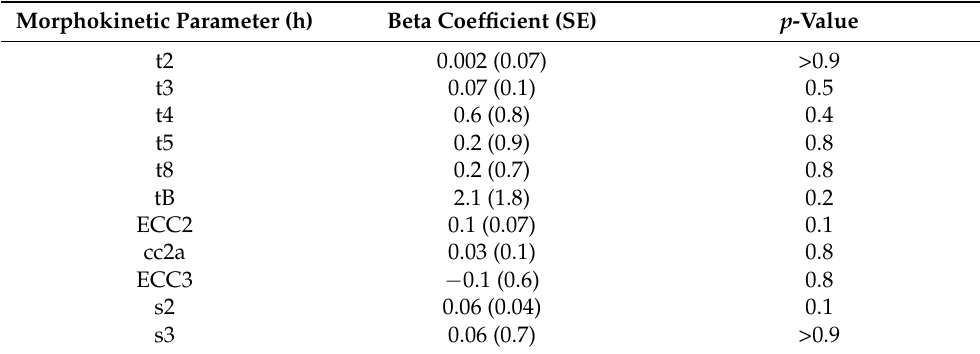
Table 5. Results of the generalized linear mixed-effects models regarding the effect of age on embryo morphokinetic parameters. Morphokinetic Parameter